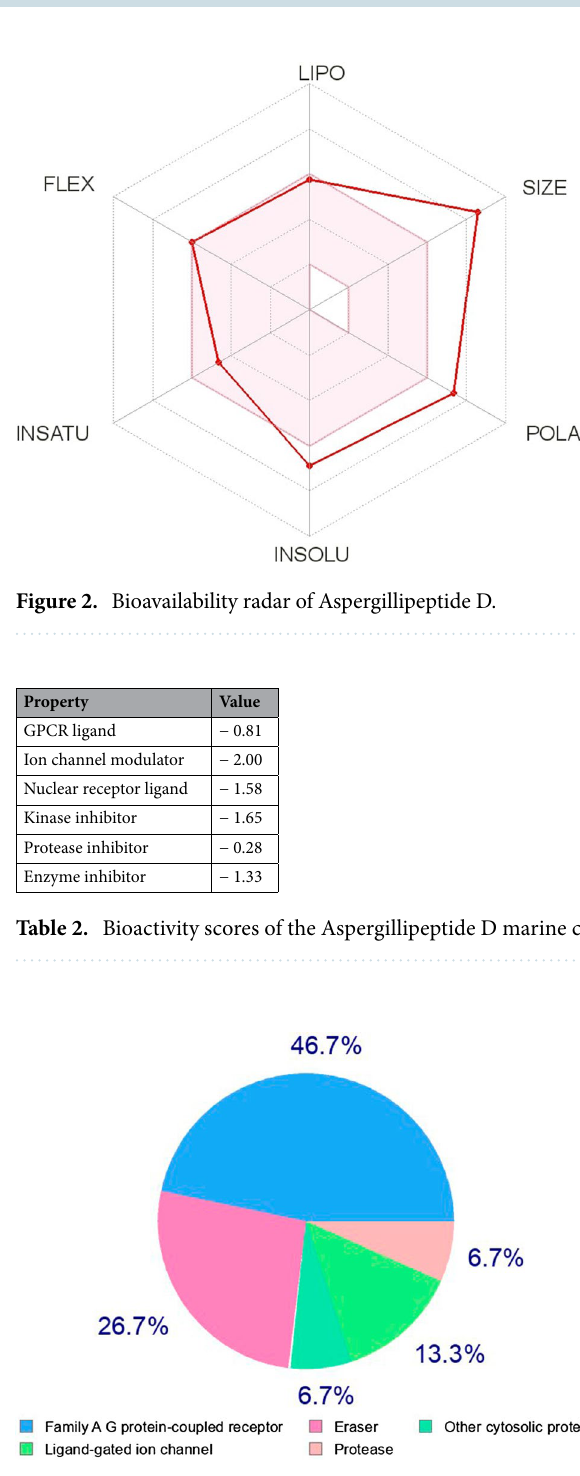
Figure 3. Predicted biological targets of Aspergillipeptide